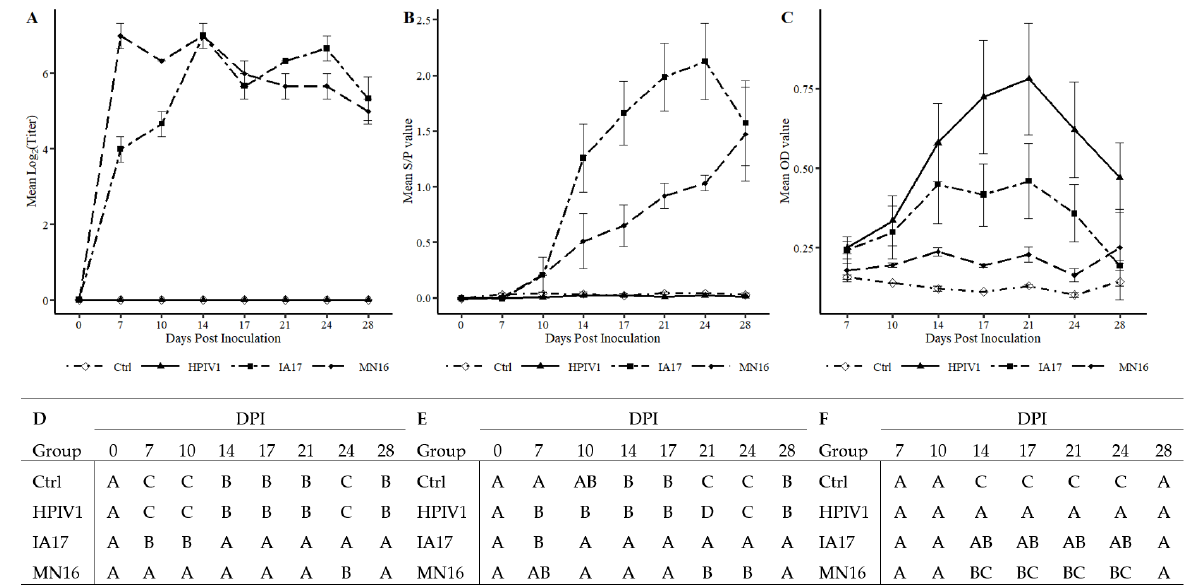
Figure 4. Antibody detection by SVN, PPIV1 wv-ELISA and HPIV1-3 ELISA in Ctrl, HPIV1, IA17, and MN16 serum. ( A ) Mean PPIV1 log 2 SVN antibody titers and SEM error bars. ( B ) Mean PPIV1 wv-ELISA S/P values and SEM error bars. ( C ) Mean OD values detected in the HPIV1-3 wv-ELISA and SEM error bars. ( D ) Connecting letters report comparing mean PPIV1 log 2 SVN antibody titers at each DPI is provided to indicate significance at p < 0.05. Groups with different letters within a column are significantly different. A Tukey–Kramer adjustment for multiple comparisons was applied to correct for family-wise error rate. ( E ) Connecting letters report comparing mean PPIV1 wv-ELISA S/P values at each DPI is provided to indicate significance at p < 0.05. Groups with different letters within a column are significantly different. A Tukey–Kramer adjustment for multiple comparisons was applied to correct for family-wise error rate. ( F ) Connecting letters report comparing mean HPIV1 OD values at each DPI is provided to indicate significance at p < 0.05. Groups with different letters within a column are significantly different. A Tukey–Kramer adjustment for multiple comparisons was applied to correct for family-wise error